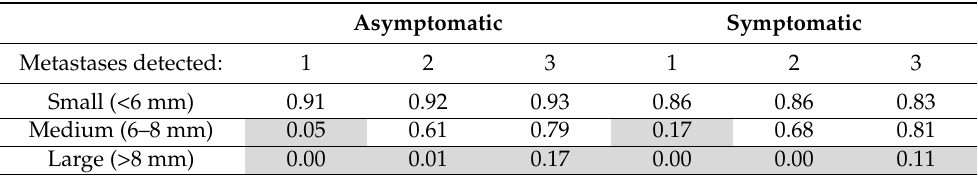
Proportions of oligo+ per risk sub-group. Grey fields represent the low-risk group. Table A8. Proportion of oligo+ within patients with detected oligo-metastases in the Symptomatic Detection Upper scenario.